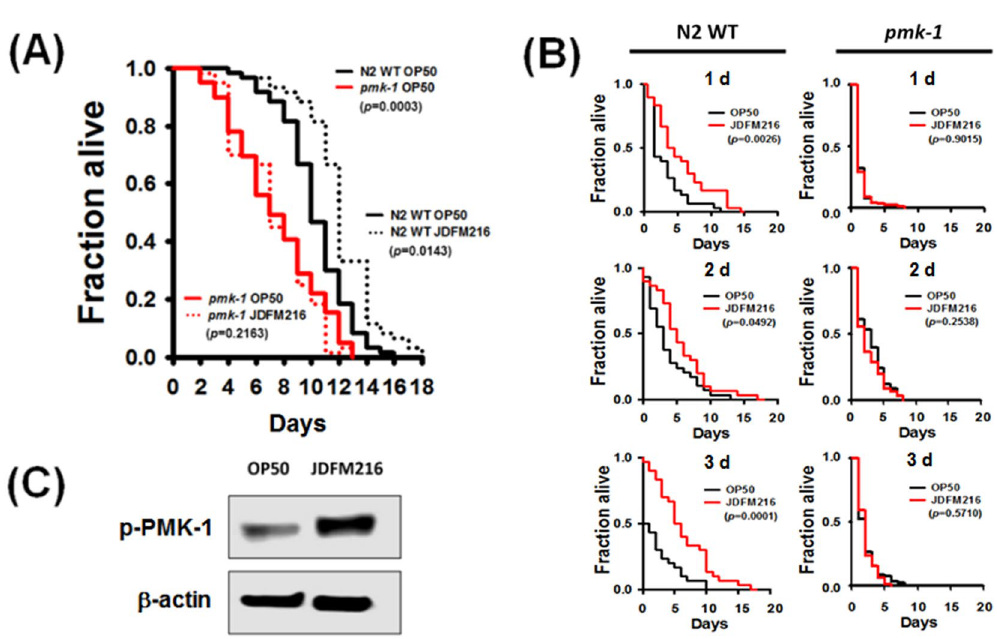
Figure 3. ( A ) PMK-1 signaling regulate the lifespan of C. elegans (Survival statistics: p = 0.0003 for pmk- 1 mutant nematodes compared with worms feeding on the E. coli OP50 control strain (n = 30 per plate). ( B ) Survival rate of wild-type N2 (left column) or pmk-1 mutant (right column) via pre-conditioning with JDFM216 for 1, 2, and 3 days prolonged the lifespan of C. elegans nematodes against S. aureus RN6390. Survival statistics: p = 0.0026 for 1 day, p = 0.0492 for 2 days, or p = 0.0001 for 3 days in N2 worms and p = 0.9015 for 1 day, p = 0.2398 for 2 days, or p = 0.5710 for 3 days in pmk-1 worms compared with worms feeding on the E. coli OP50 control strain (n = 30 per plate). ( C ) Immunoblot analysis of PMK-1 activation in whole worm lysates of worms by JDFM216 using the phosphorylated PMK-1 (p-PMK-1). β -actin was used as a loading control. The blots were cropped and full length blots are presented in Supplementary Figure